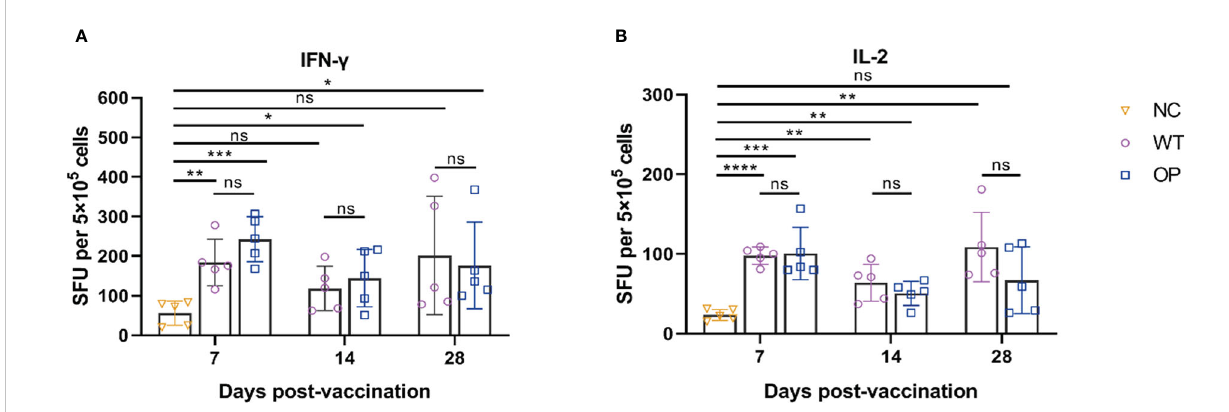
FIGURE 3 CHIKV-speci fi c T-cell responses induced by CHIKV mRNA vaccine. mRNA vaccine was administered to mice and the splenocytes were harvested and analyzed. (A) IFN- g -secreting cells and (B) IL-2-secreting cells were quanti fi ed by ELISpot assay. n = 5 mice per group; each data point represents the mean number of spots per well. * p < 0.05; ** p < 0.01; *** p < 0.001; **** p < 0.0001; ns: p > 0.05. NC, negative control; SFU, spot forming units; WT, wild-type vaccine; OP, codon-optimized